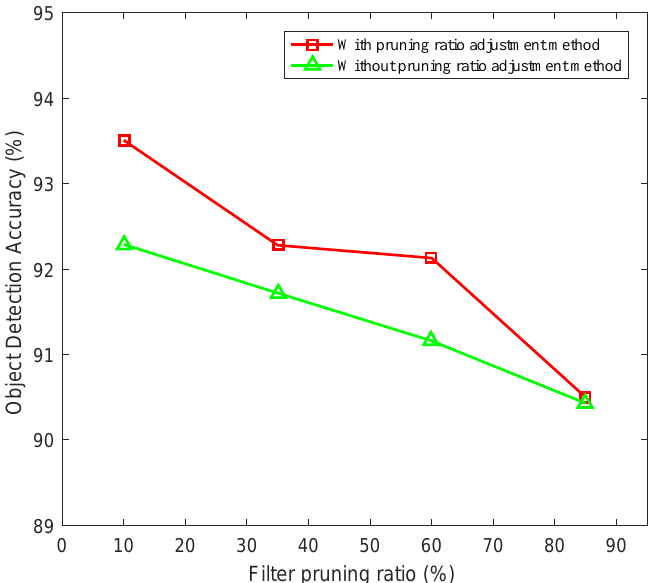
Figure 8. Comparison of CenterNet101 in the absorption pruning with and without the pruning ratio adjustment